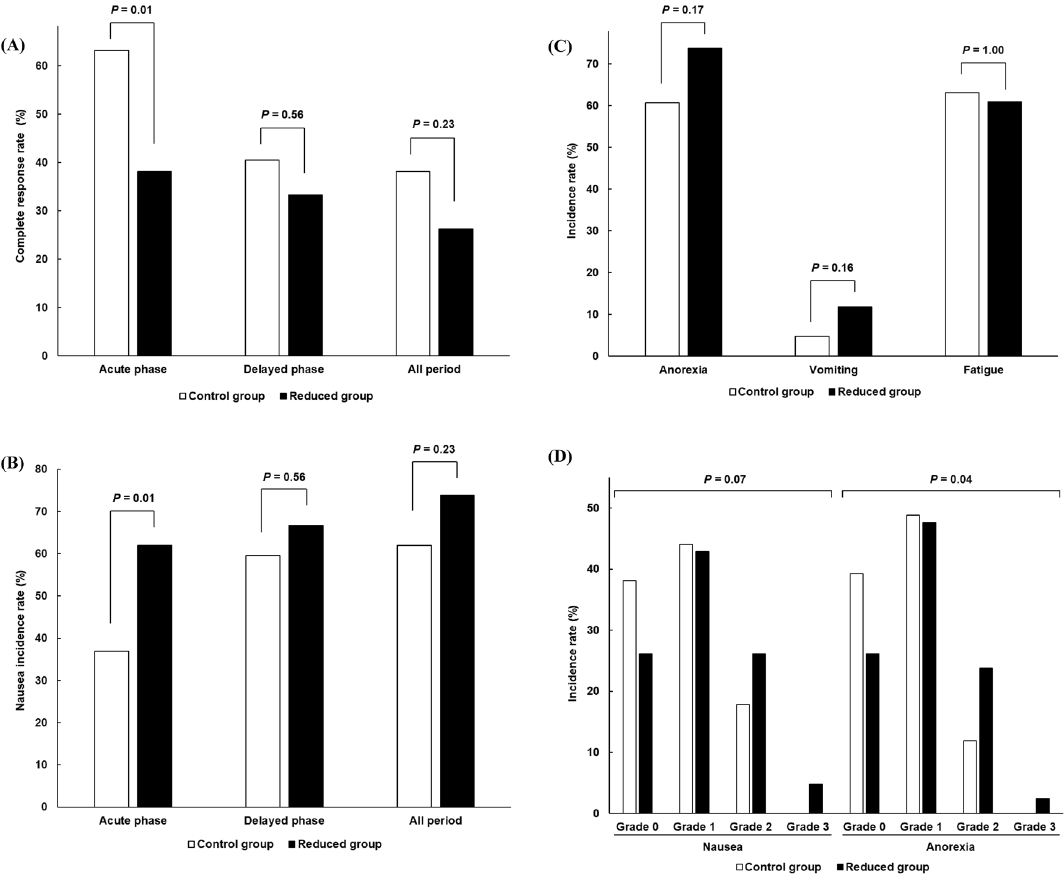
Figure 2. Comparison of the ( A ) CR rate; the incidence of ( B ) nausea, ( C ) anorexia, vomiting, and fatigue; and the ( D ) severity of nausea and